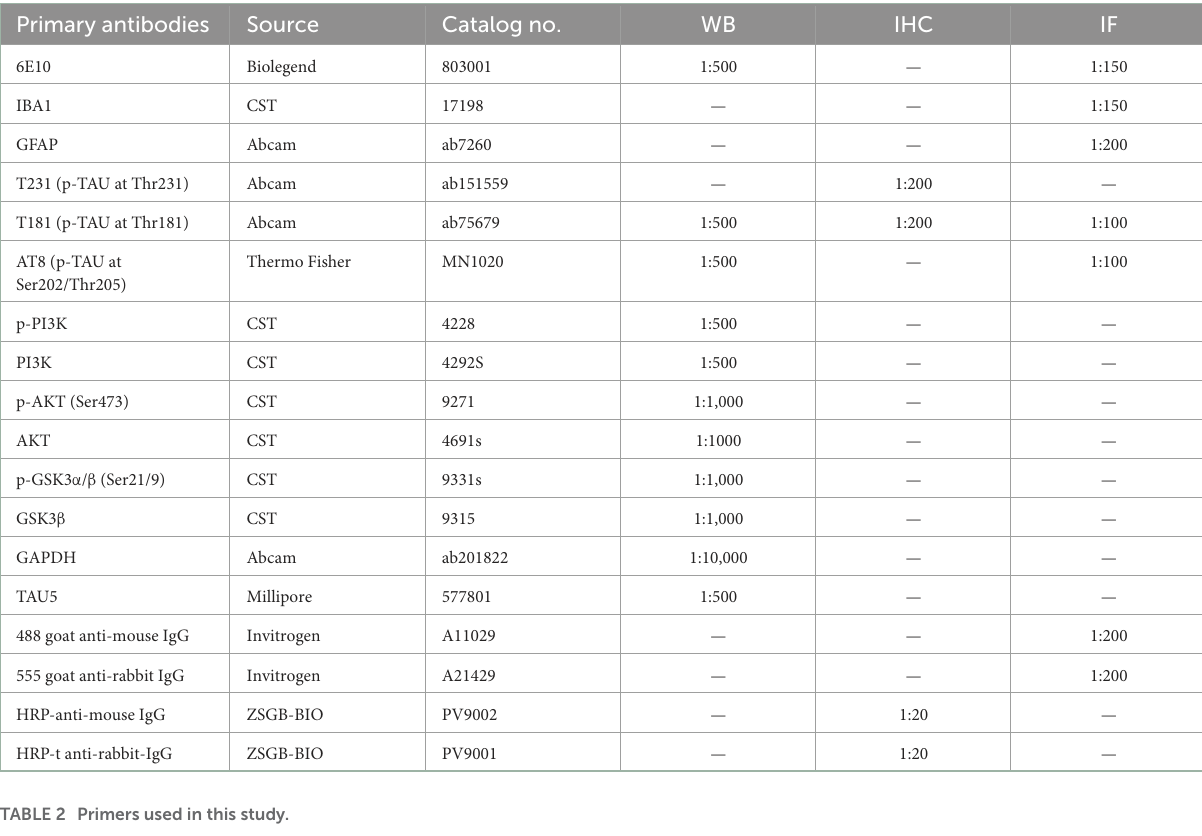
TABLE 1 Antibodies used in this study. Primary antibodies